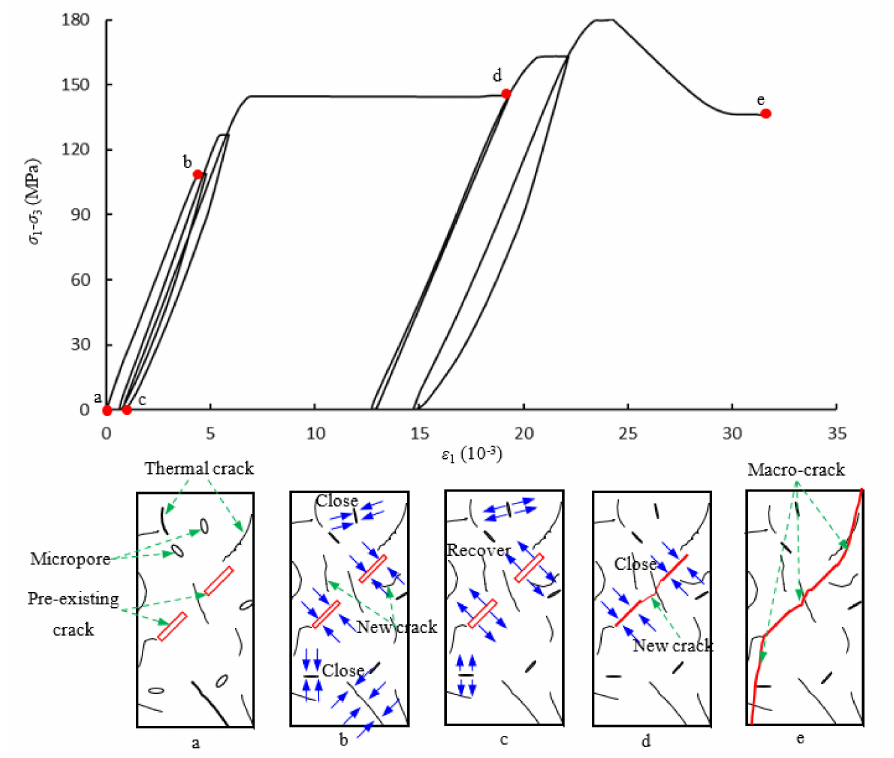
Figure 12. Relationships between stress ratio and steady-state strain ratio and damage after different temperature